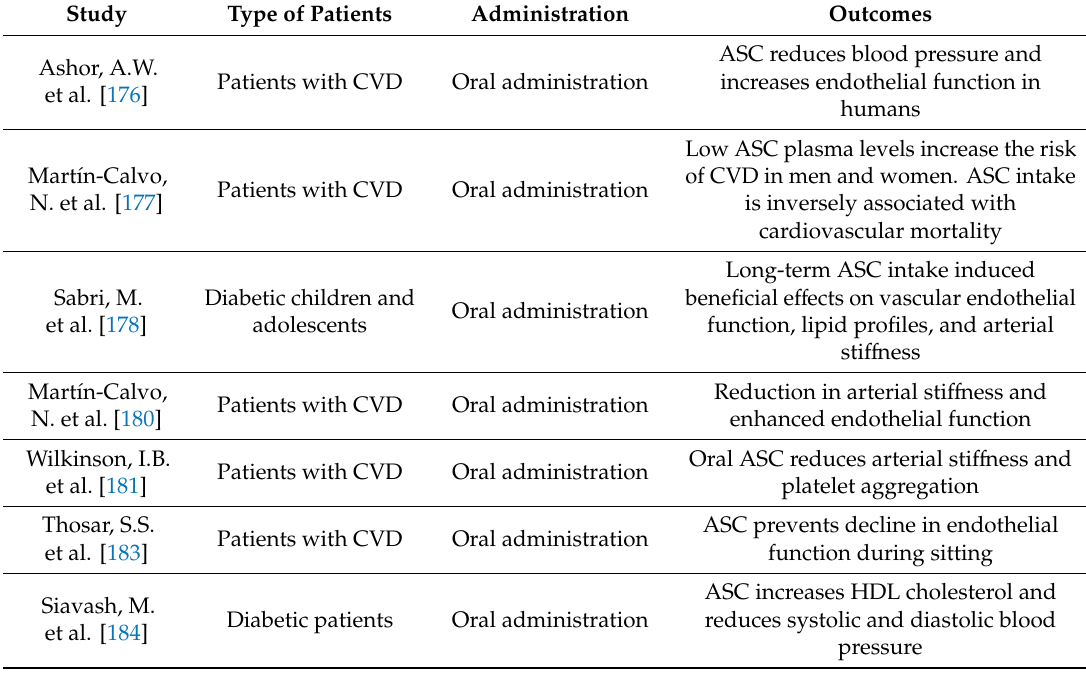
Table 6. Clinical trials and meta-analysis available for patients with cardiovascular diseases (CVD treated with